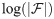
Mixing as a function of the number of interactions.Plots compare empirical data and hybrid simulations. Entropies are normalized by log(|F|), solid lines show the empirical mean over the three experiments, dashed lines represent means over hybrid simulations. Shaded areas depict standard deviations. (a) The mixing entropy, Hmix, in simulations with maximally mixing interactions applied over the empirically measured network (green curve) nearly saturates the empirically assessed upper bound Htypes (blue curve). Mixing entropy, Hmix, in simulations where the empirically derived interaction rule is applied over maximally mixing interaction networks shows a limited rise which compares with empirical mixing rates (red curve). (b) Hybrid simulations of two extreme interaction rules preserving the empirically measured interaction schedule. The orange curve shows Hmix using only the transfers between foragers and non-foragers (i.e., all non-forager to non-forager interactions were set to zero). The green curve depicts Hmix where every transfer is assumed to be at its maximal possible volume. These rules lead to mixing levels that are lower than those measured experimentally (red curve). Discontinuities in the plots are a consequence of the variable number of interactions among the three experiments.